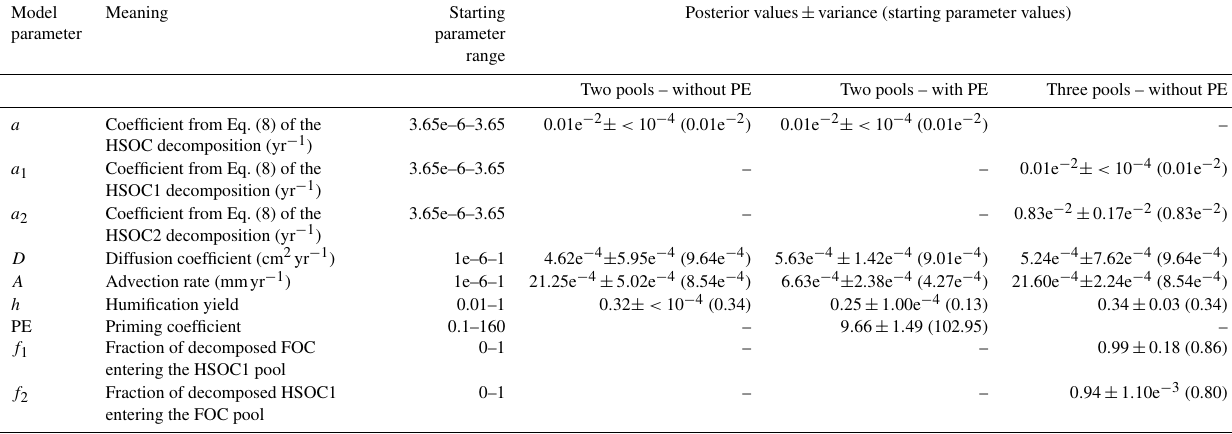
Table 5. Summary of optimized model parameters. Model Meaning Starting Posterior values ± variance (starting parameter values) parameter parameter range Two pools – without PE Two pools – with PE Three pools – without